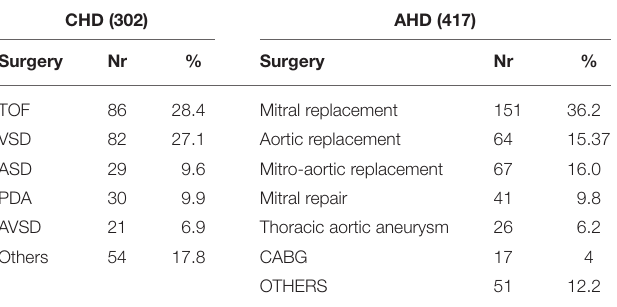
TOF, Tetralogy of Fallot; VSD, Ventricular Septal Defect; ASD, Atrial Septal Defect; PDA, Patent Ductus Arteriosus; AVSD, Atrio-Ventricular Septal Defect; CABG, Coronary Artery Bypass Graft Surgery; PM, Pacemaker; ECG, Electrocardiogram.